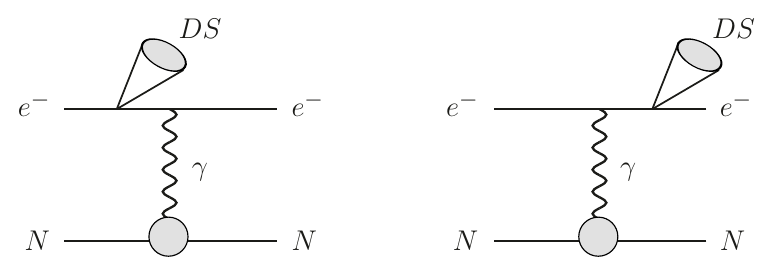
Figure 9 . Feynman diagrams characterizing direct DS production at fixed target experiments with electron beams like NA64 and E137. The DS particles can be radiated off the initial or final electron line through the D = 6 portal (¯ eγ µ e ) J µ DS